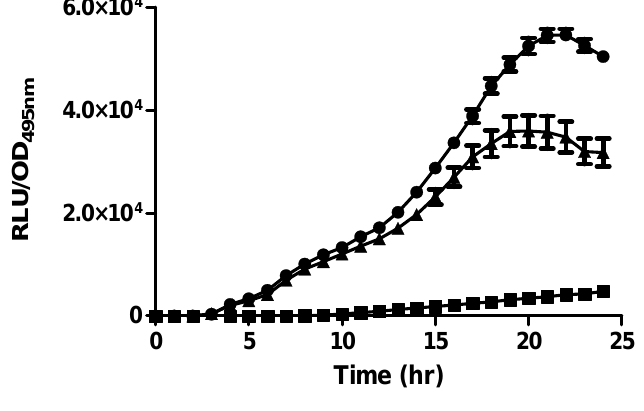
Figure 3. Detection of short chain AHL or AHLs produced by Burkholderia sp. strain A9 via bioluminescence of the biosensor E . coli [pSB401]. Synthetic 3-oxo-C6-HSL (circle) (positive control), acetonitrile (square) (negative control), and AHL extract from the spent culture supernatant of A9 (triangle) were presented to E . coli [pSB401]. Error bars represent the standard error of the mean for three